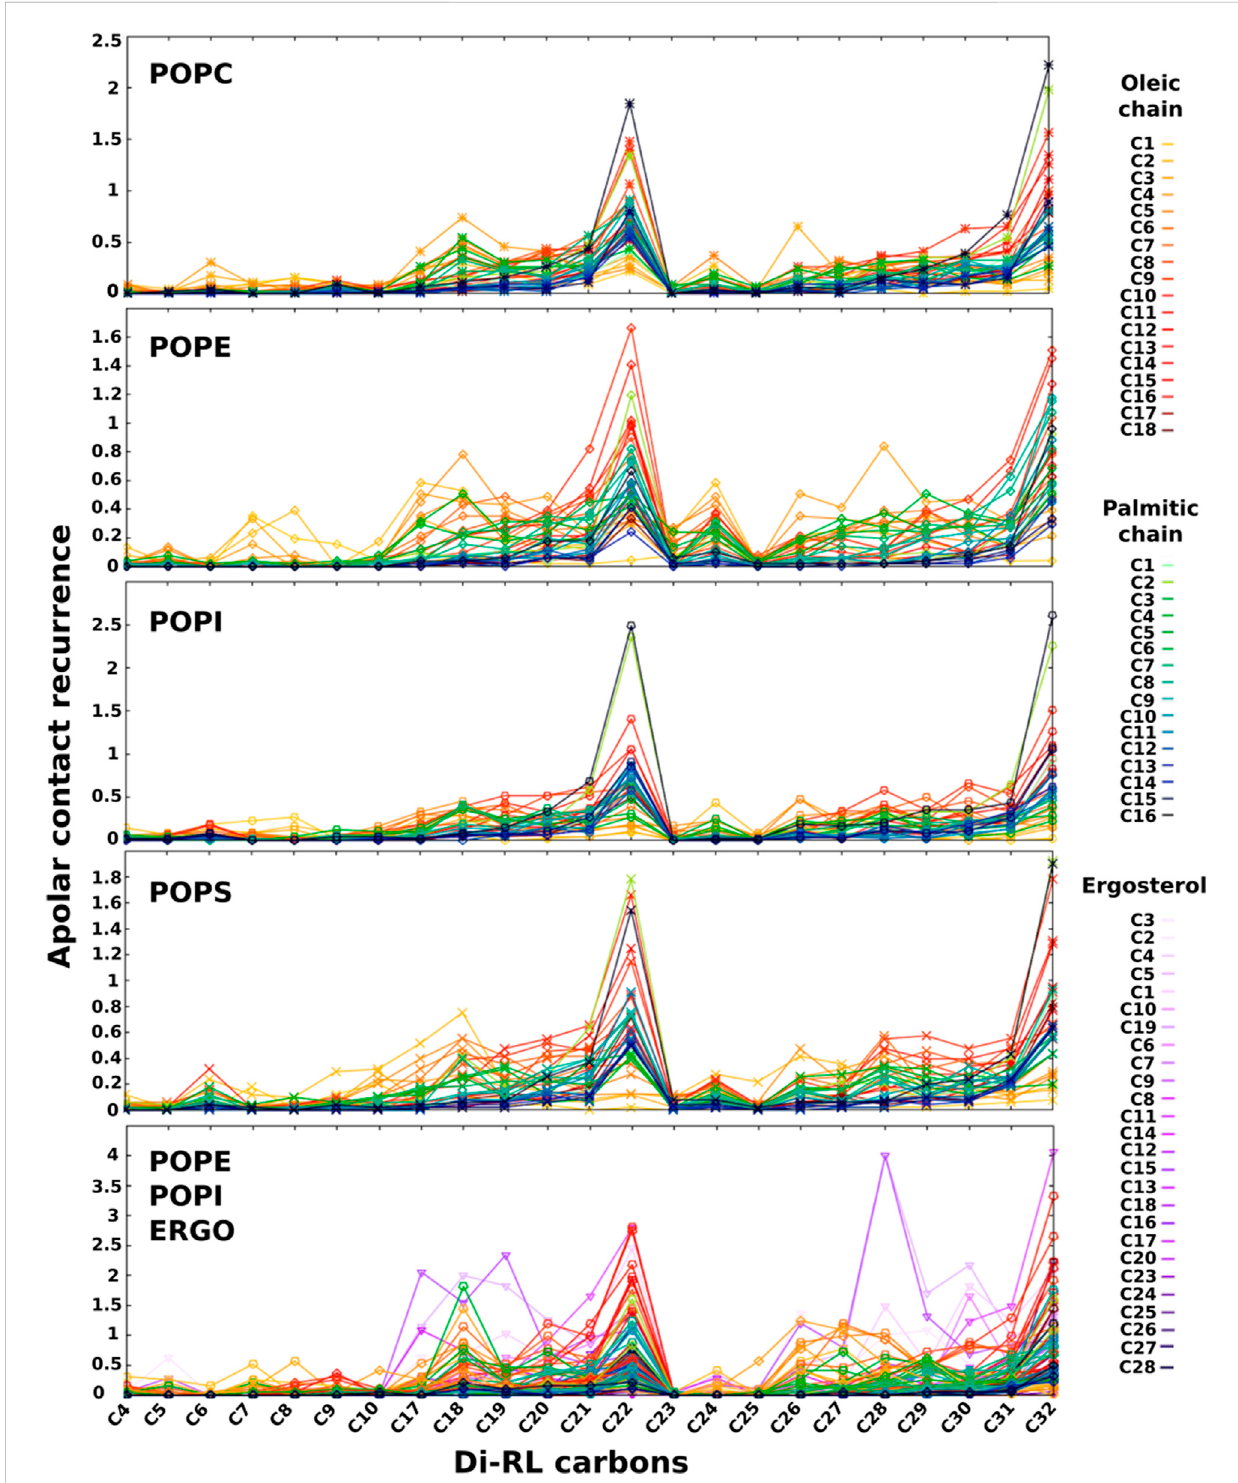
FIGURE 6 Recurrence of close contacts between apolar atoms of di-RLs and those of phospholipids and ergosterol, indicating the formation of van der Waals contacts. Membranemodels:POPC; POPE;POPI;POPS; asimpli fi edmodeloffungal membrane composedofPOPE,POPIandERGO (35/35/30).Atoms coloured from light green to dark blue refer to oleic acyl chain while those coloured from yellow to dark red refer to palmitic acyl chain. Colour tonality re fl ects the distance from the headgroup. Carbons are numbered in order from the carbonyl group for palmitic and oleic chains. Ergosterol carbon numbering is depicted in Supplementary Figures